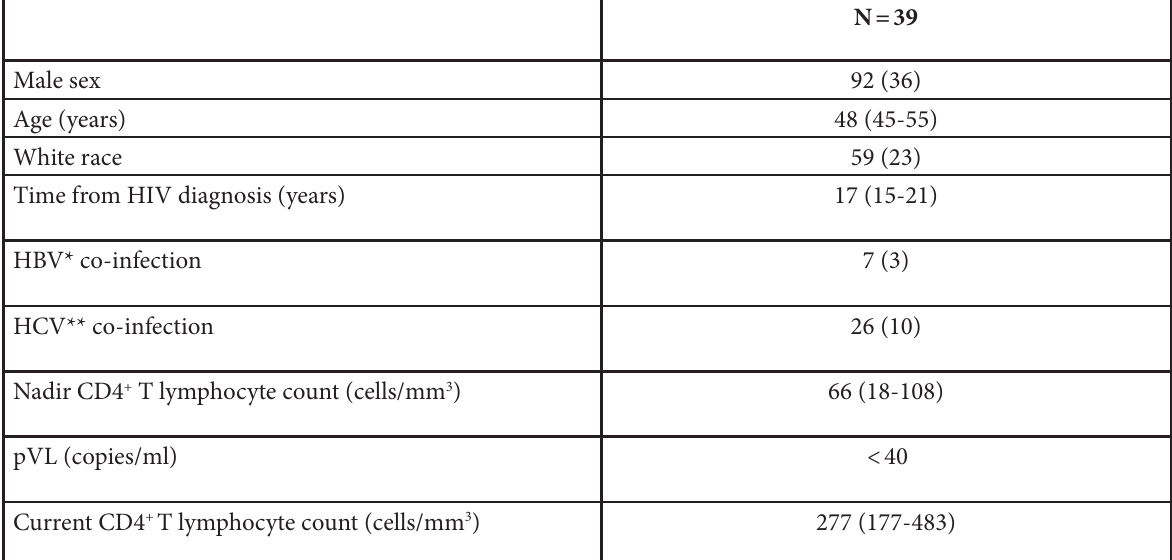
Table 1: Clinical characteristics of studied